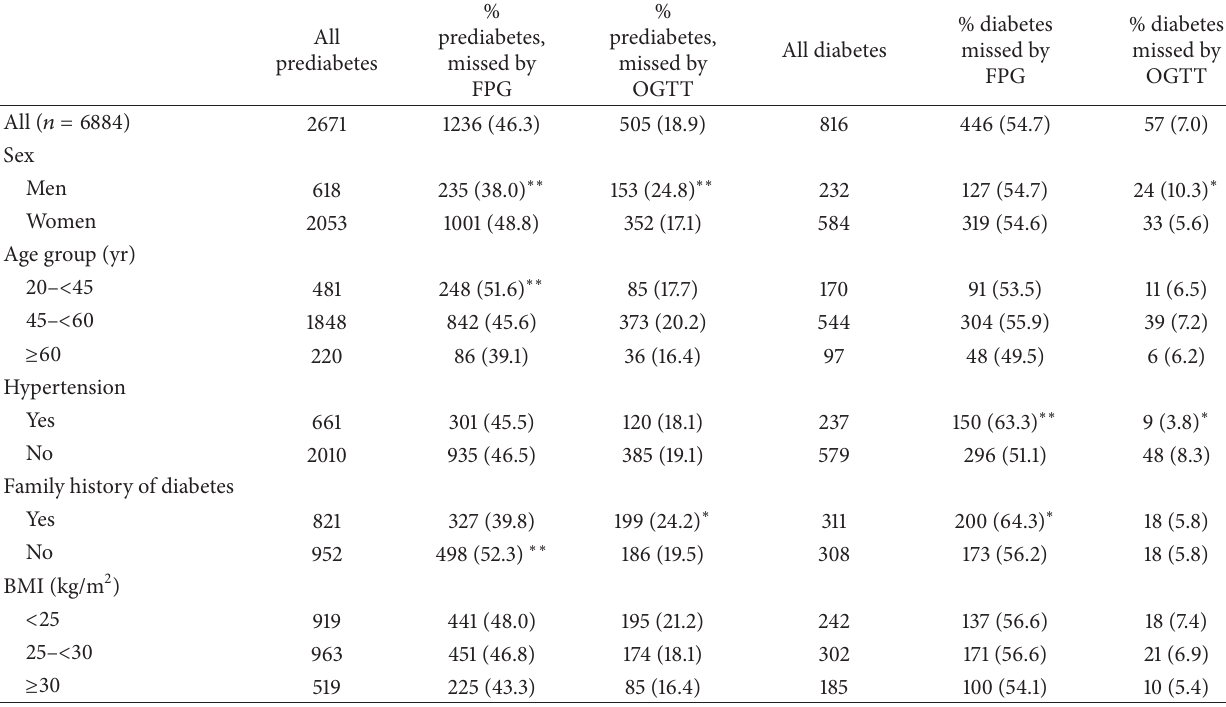
Table 3: Percentages of prediabetes and diabetes missed by FPG and